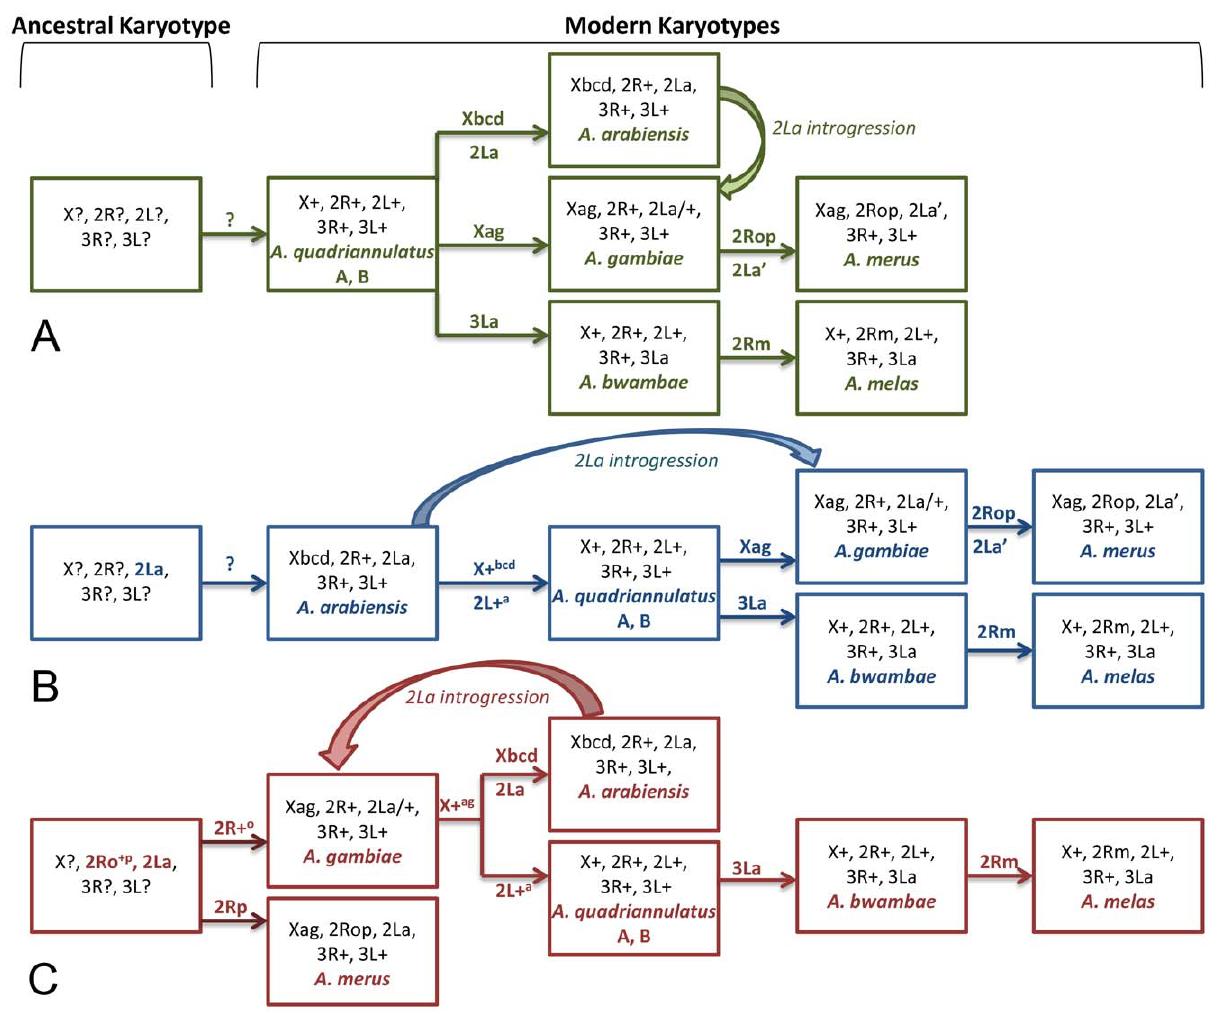
Figure 8. Alternative scenarios of karyotypic evolution in the An.gambiae complex. ( A ) A chromosomal phylogeny based on the ancestral state of the ‘‘standard’’ karyotype of An. quadriannulatus [4,7]. ( B ) A karyotypic evolution based on the ancestral position of the An. arabiensis karyotype inferred from the finding of the fixed 2La inversion in outgroup species [18]. Scenarios A and B assume an independent origin of the 2La 9 inversion in An. merus . ( C ) A chromosomal phylogeny based on the established ancestry of the shared inversion 2La [20] and arrangements 2Ro and 2R + p (this study). The introgression of 2La from An. arabienstis to An. gambiae is shown in all three scenarios. Inversion fixation events are shown above and below